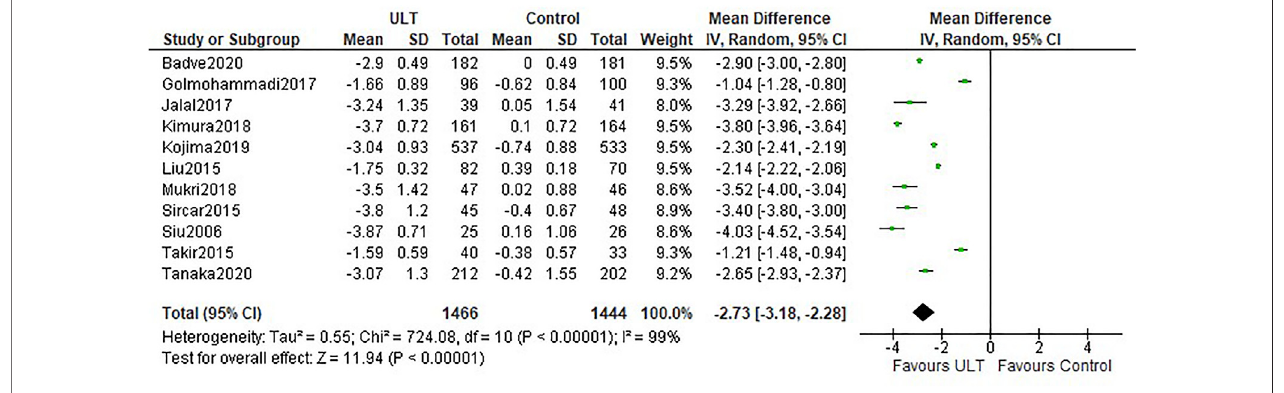
FIGURE 4 | Uric acid levels: ULT vs control